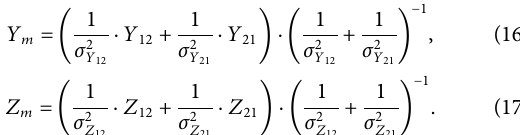
Schematic diagram of the experimental setup.